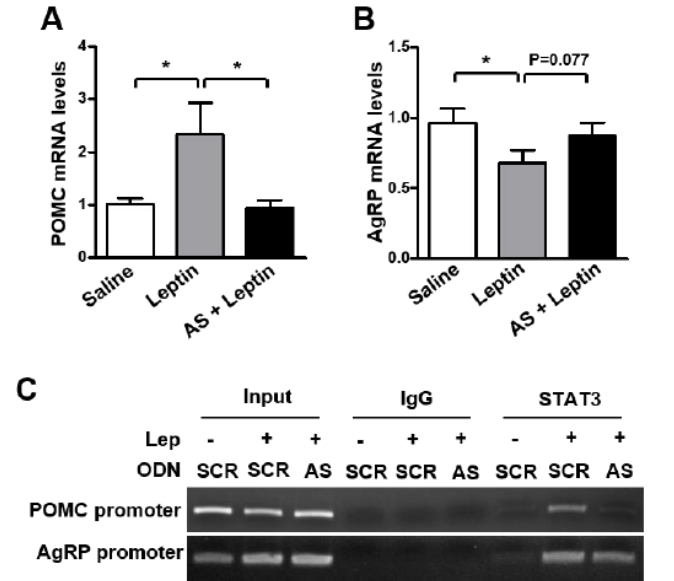
Figure 4. Effect of SPX synthesis blockade on leptin-induced changes in POMC and AgRP ex- pression. Eight-week-old male mice were icv-injected with 2 µ g of the AS or SCR ODN once a day for 2 days and fasted for 24 h after the second ODN injection. Then, mice were icv-injected with leptin (2.5 µ g) and MBH samples were collected 3 h after leptin injection. ( A , B ) RNA samples were isolated from MBH tissues and were analyzed to determine POMC ( A ) and AgRP ( B ) mRNA levels using qRT-PCR. ( C ) ChIP assays showing the effect of AS ODN-mediated SPX synthesis blockade on the leptin (LEP)-induced increase in STAT3 binding onto the POMC and AgRP promoters. Nuclear DNA samples from MBH tissues were immunoprecipitated with anti-STAT3 antibody or mouse IgG and were analyzed by PCR amplification using primers specific to mouse POMC and AgRP promoters. Input represents the DNA extracted from the MBH before immunoprecipitation. Data are presented as mean ± S.E.M. *, p < 0.05.